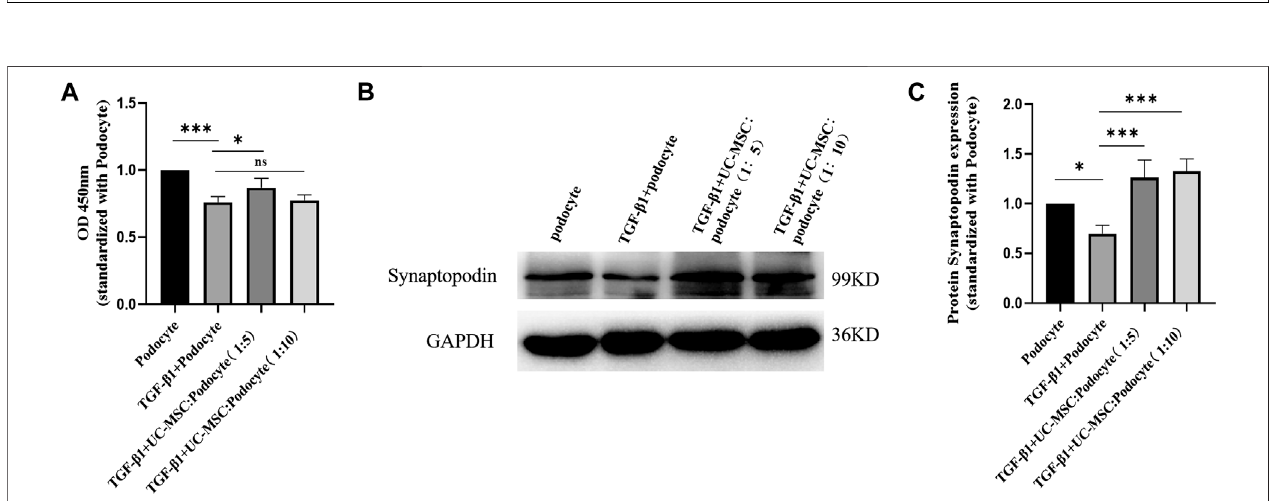
FIGURE5| UC-MSCrestoredactivityandsynaptopodinexpressioninpodocytesstimulatedbyTGF- β 1. (A) Comparisonofthepodocyteactivity. (B) Westernblot results of synaptopodin. (C) Comparison of synaptopodin protein expression. ns: no signi fi cance; * p < 0.05; ** p < 0.01; *** p < 0.001.